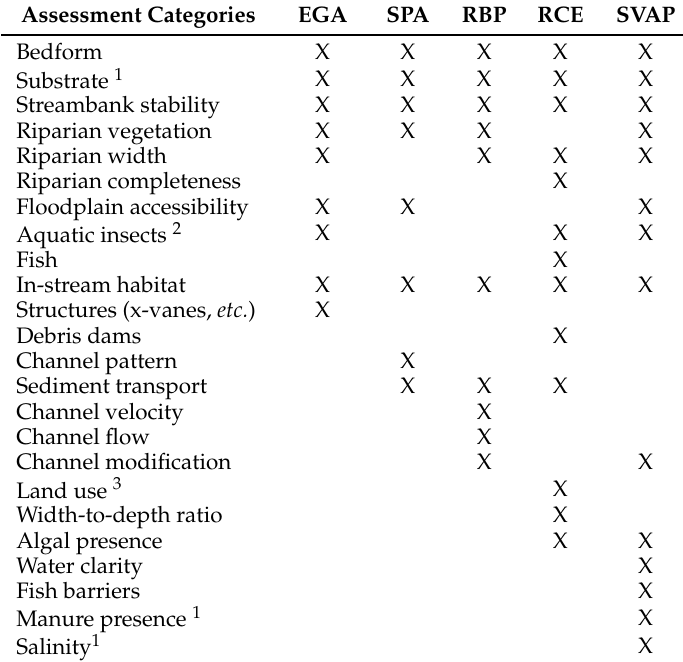
Table 4. Variable comparisons among five rapid stream assessment